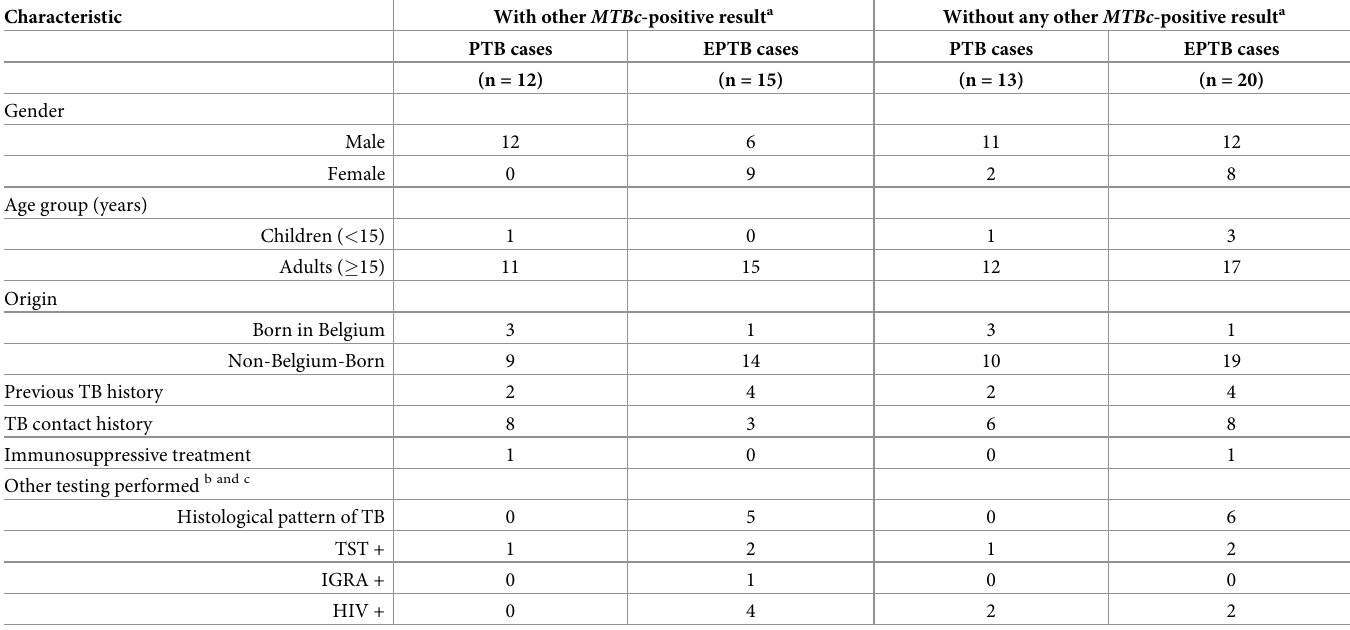
Table 3. Clinical and demographic characteristics of patients with apparent false-positive Xpert Ultra results and a final diagnosis of active TB.